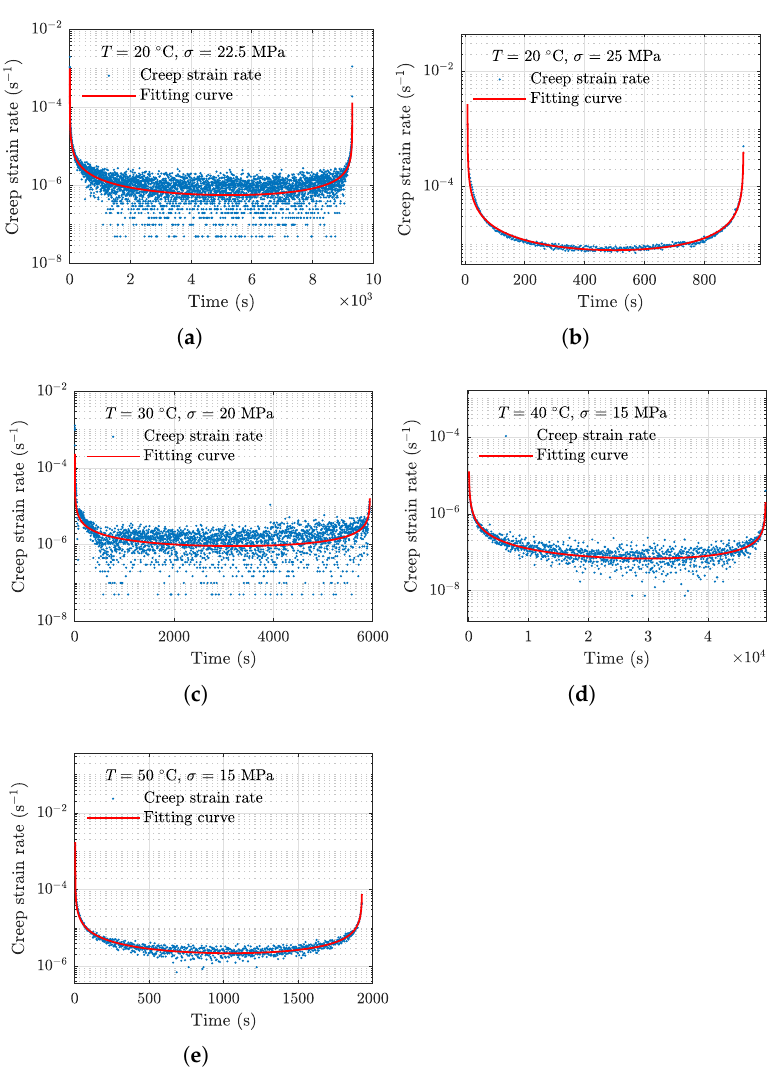
Figure 7. Results of mean curves obtained using Equation (5). ( a ) 20 ◦ C, 22.5 MPa, ( b ) 20 ◦ C, 25 MPa, ( c ) 30 ◦ C, 20 MPa, ( d ) 40 ◦ C, 15 MPa, and ( e ) 50 ◦ C, 15